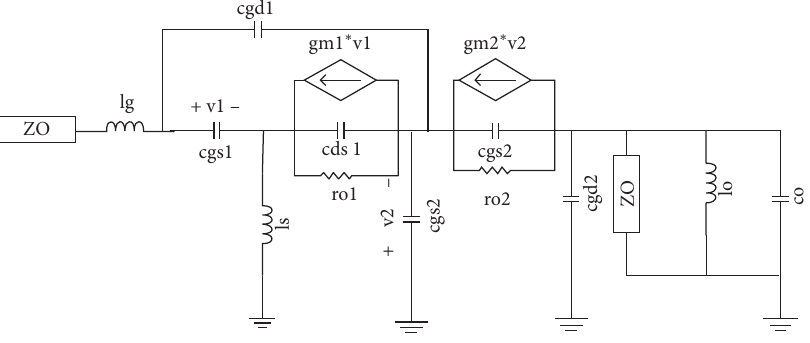
Figure 9: The equivalent circuit of the cascode LNA.